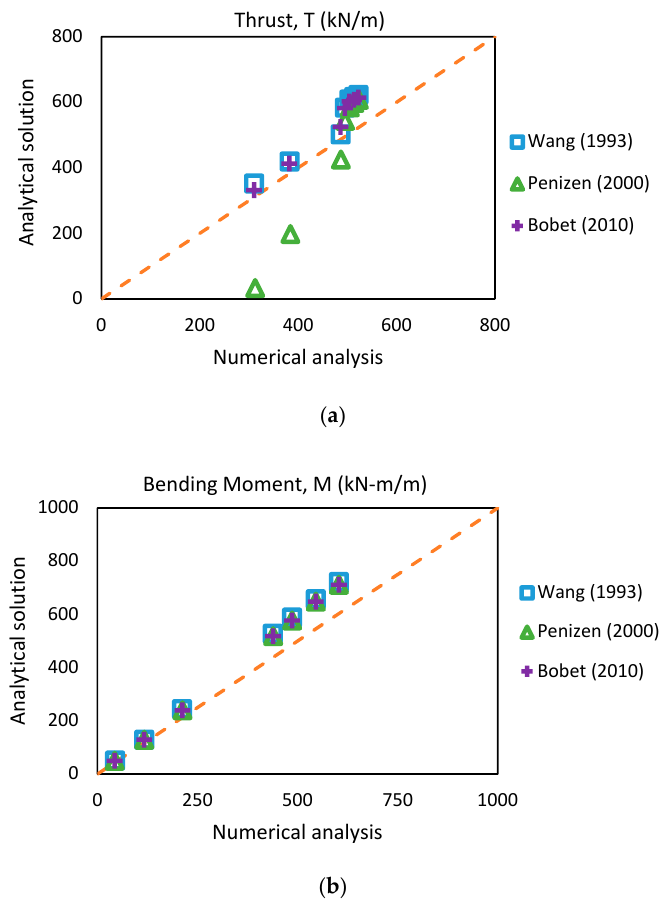
Figure 1. Comparison between numerical and analytical solutions: ( a ) thrust and ( b ) bending moment [16].